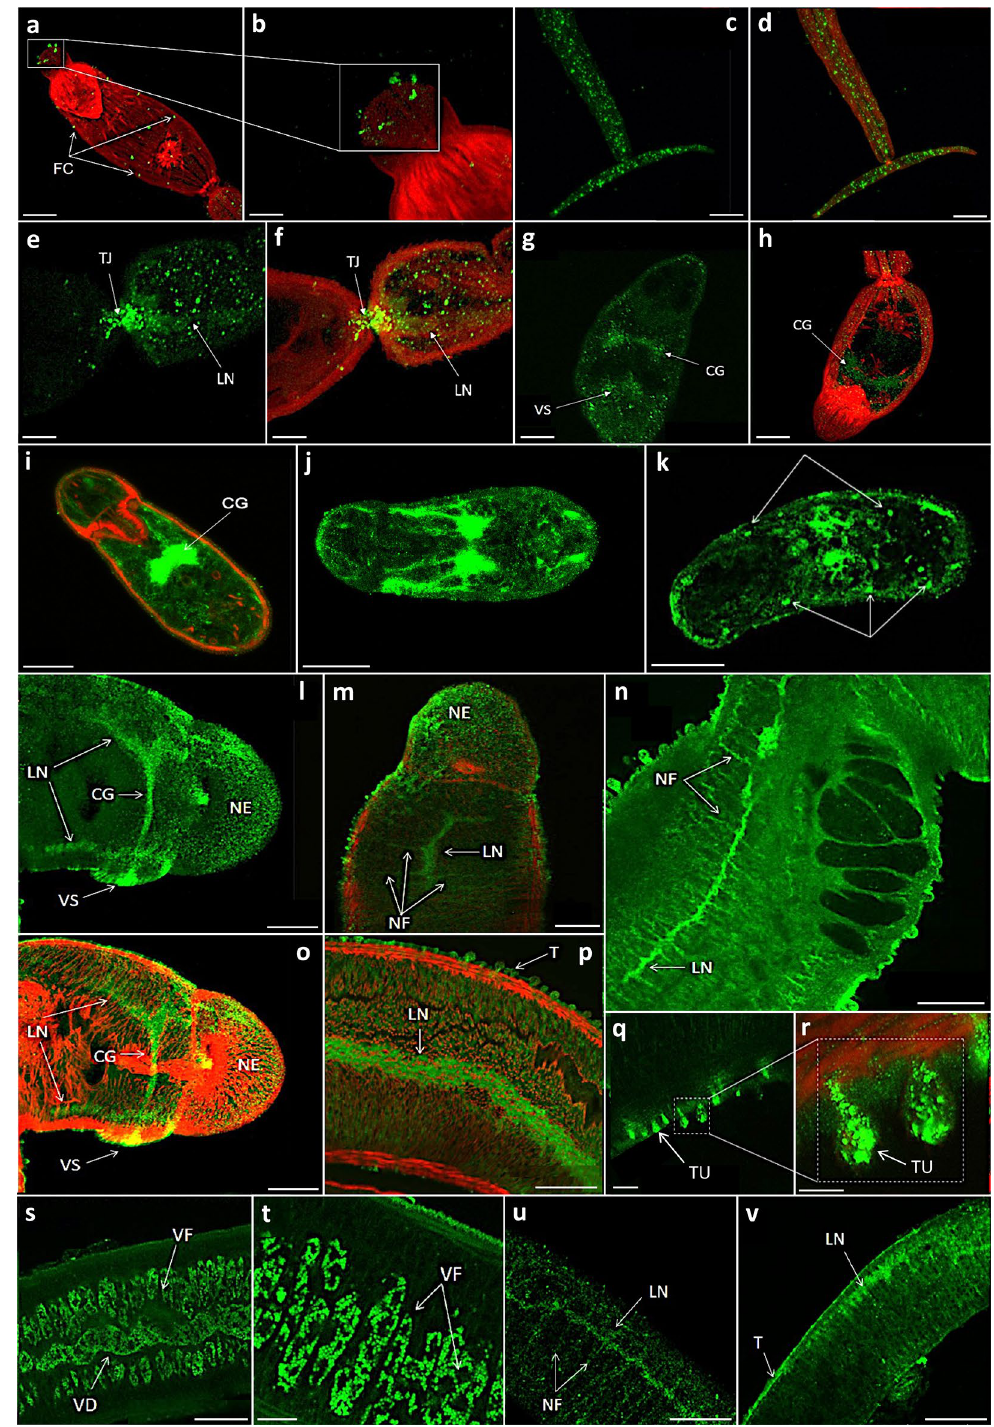
Figure 4. In situ immunolocalization of phosphorylated (activated) CaMKII in intact Schistosoma mansoni cercariae, schistosomula and adult worms. ( a – h ) Cercariae, ( i – k ) 24 h in vitro cultured schistosomula, ( l – r ) male, and ( s – v ) female worms were fixed and incubated with anti-phospho-CaMKII (Thr 286 ) antibodies, followed by Alexa Fluor 488 secondary antibody (green); parasites were also stained with rhodamine phalloidin (red; shown in some images as overlays) to reveal actin filaments. Images are z-axis projections of either the whole parasite or of deep scans within the parasite displayed in maximum pixel brightness mode except for j, k, q, and r which are derived from single z-scans. Scale bar: b, e, f, r, t = 10 µm; a c, d, g–k, q, s = 25 µm; l–p, u, v = 50 µm. Abbreviations: CG, cephalic ganglion; FC, flame cells; LN, longitudinal nerve; NE, nerve endings; NF, nerve fibres; T, tegument; TJ, tail junction; TU, tubercles; VD, vitelline duct; VF, vitelline follicles; VS, ventral